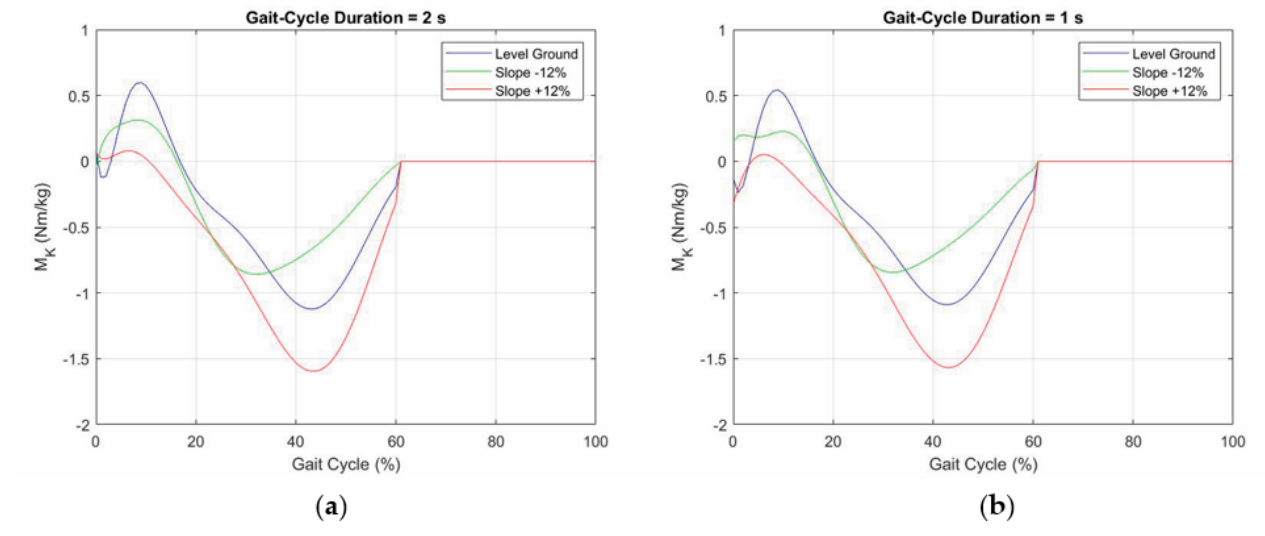
Figure 15. Internal torque, M K , of the knee prosthesis computed with Equation (6) for J = 0.274 kg m 2 and two gait-cycle durations: ( a ) 2 s and ( b ) 1 s.